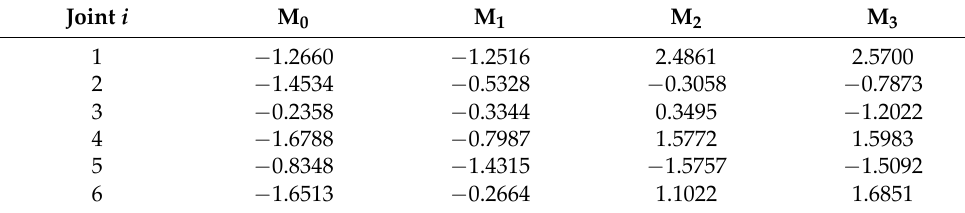
Table 3. Angular position of robot joint space (rad).